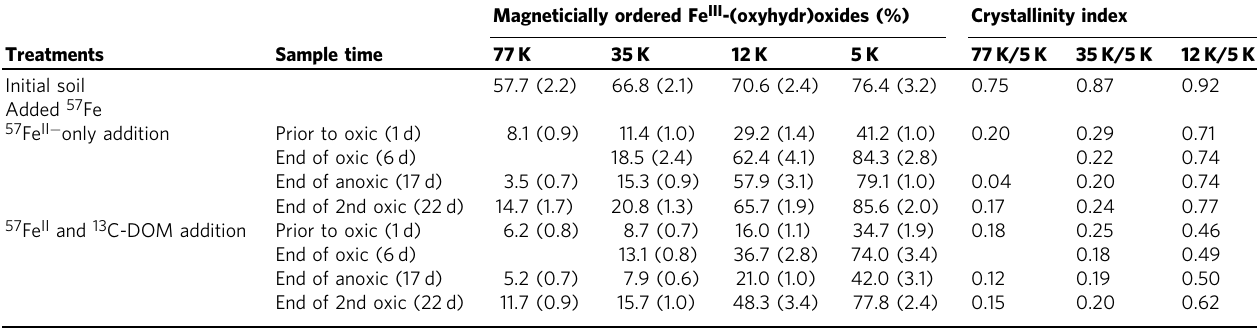
Table 1 Relative abundance of magnetically ordered Fe III (oxyhydr)oxides in 57 Fe Mössbauer spectra of the initial unreacted soil and the amended 57 Fe (corrected to exclude the signal from the native soil Fe), as a function of temperature.